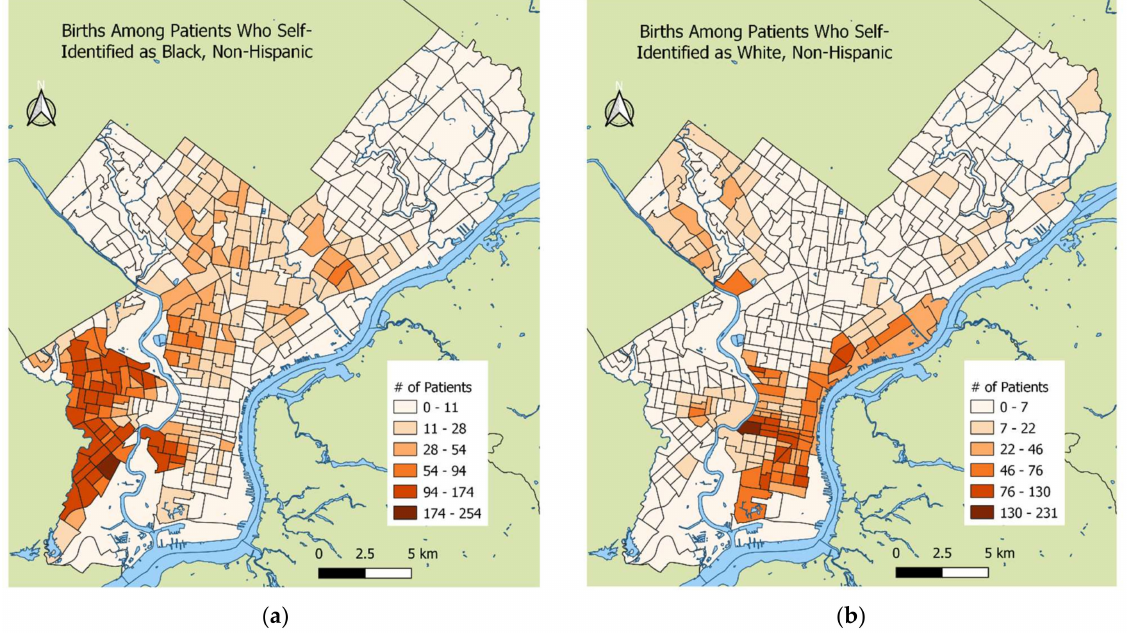
Figure 4. Maternal race by census tract. ( a ) Patients who self-identified as Black, Non-Hispanic; ( b ) Patients who self-identified as White